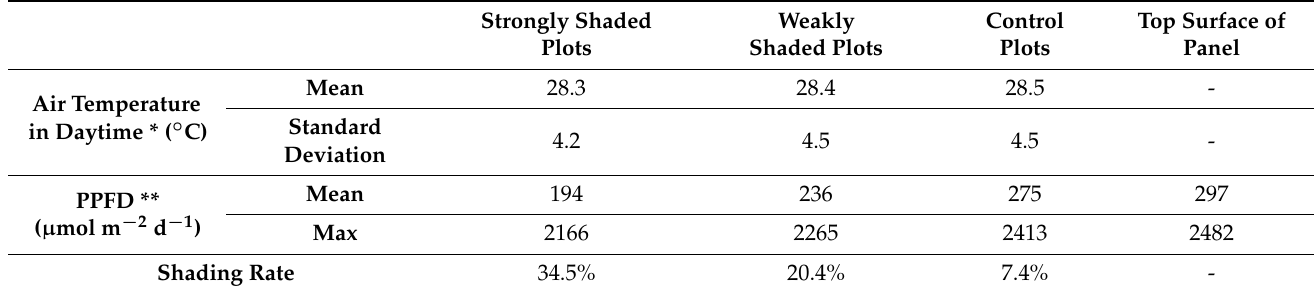
Strongly Shaded Plots